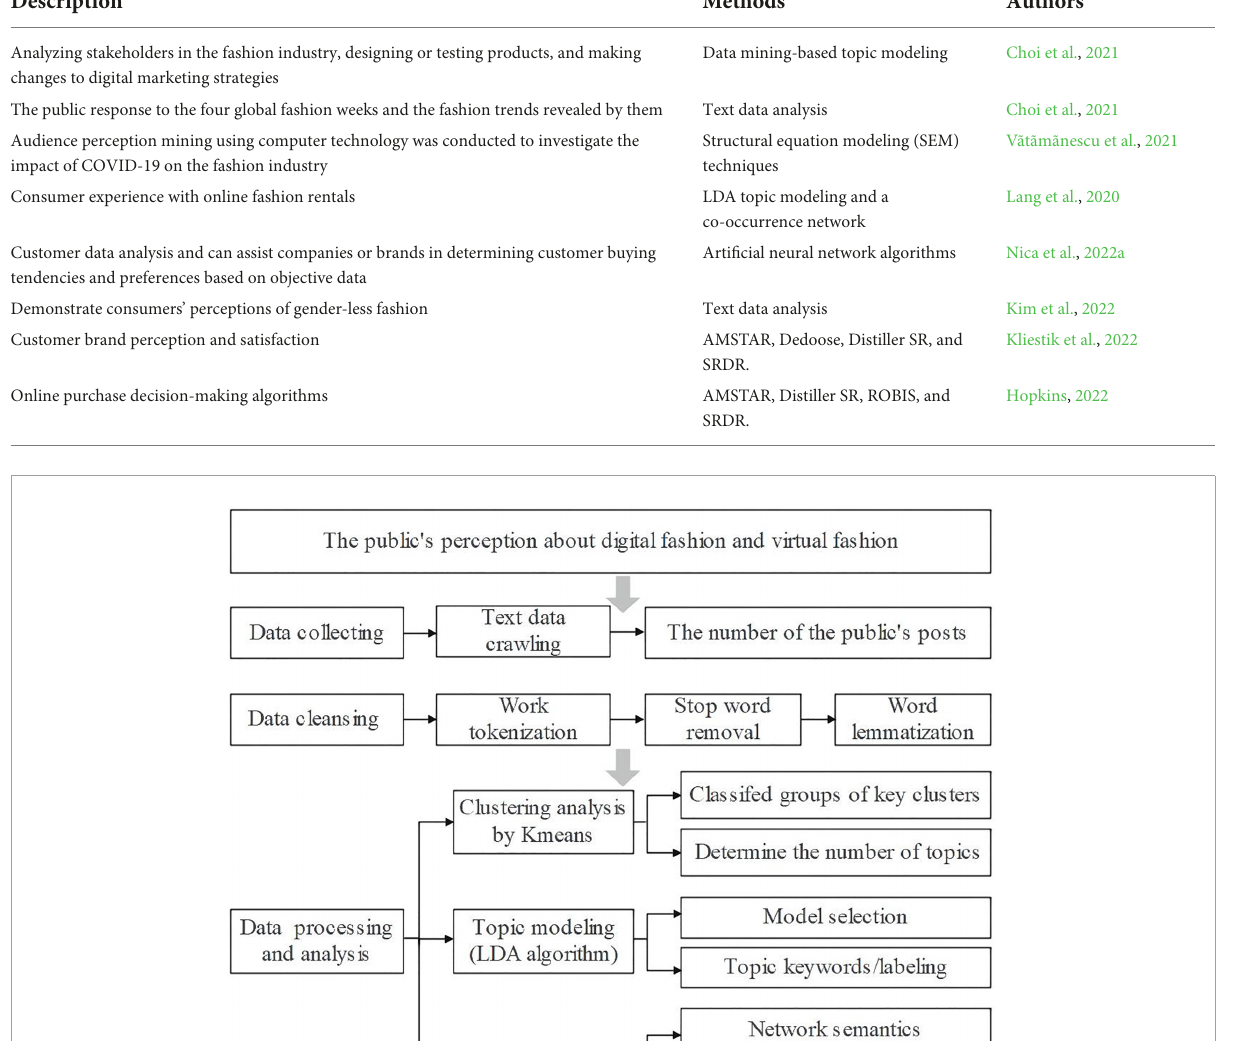
TABLE 1 Existing relevant studies in fashion field.